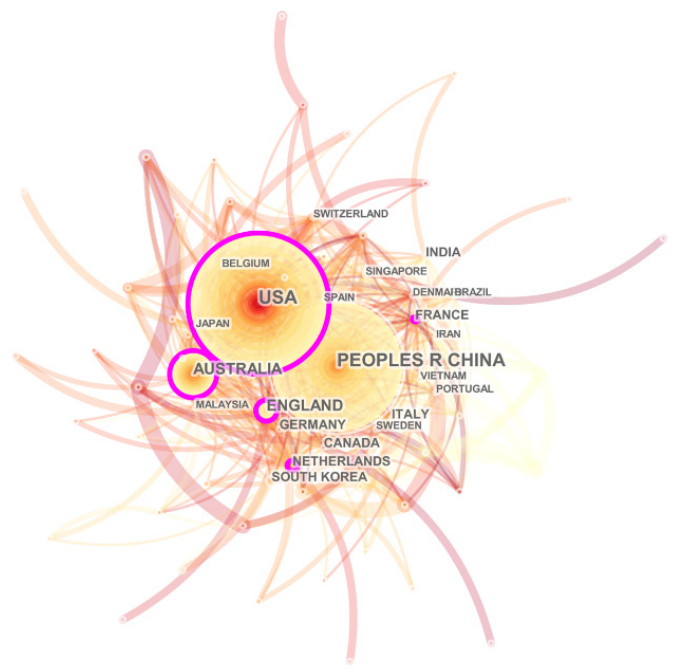
Figure 3. Countries’ cooperation network.